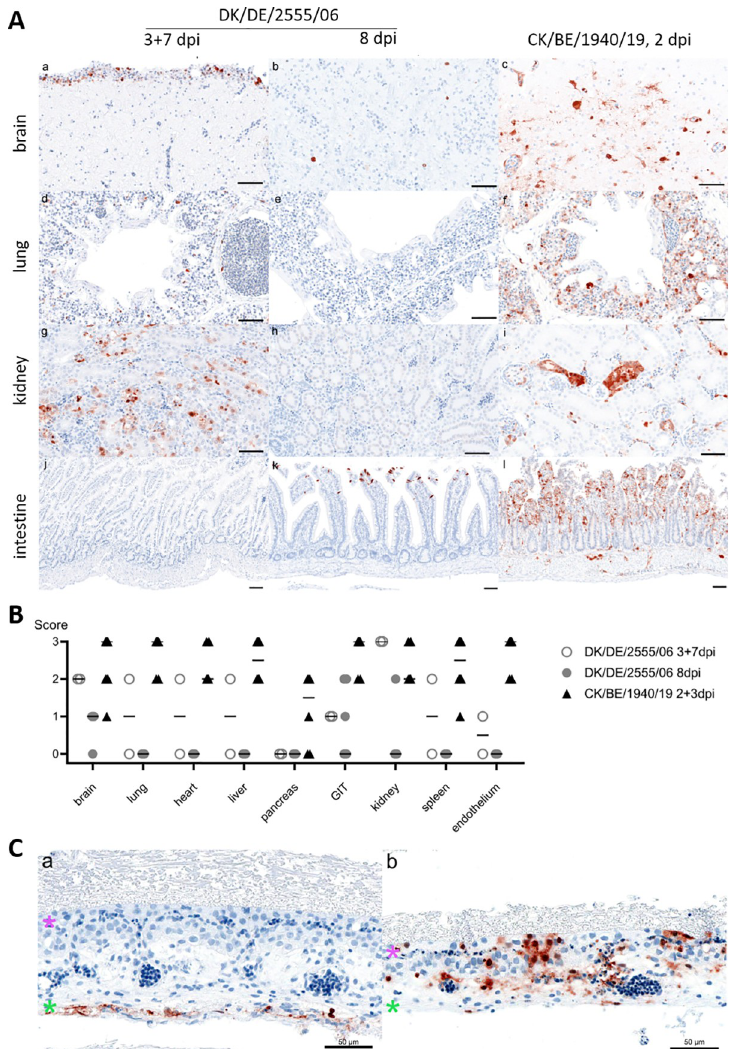
Fig 3. Tissue tropism of DK/DE/2555/06 and CK/BE/1940/19 following ICPI and inoculation of embryonated chicken eggs. (A) Representative images of IAV matrix protein (M1) detected in brain (a-c), lung (d-f), kidney (g-i) and intestine (j-l), following intracerebral inoculation of day-old chicks; time points indicate days post inoculation (dpi). ABC method, AEC chromogen (red), counterstain haematoxylin (blue). Bar = 50 μ m. (B) Summary of semi- quantitative antigen detection in parenchymal cells of indicated organs. Dots represent individual animal tissue scores: 0 = no antigen, 1 = focal to oligofocal, 2 = multifocal, 3 = coalescing/diffuse. Bar indicates median, GIT = gastrointestinal tract. Details given in S1 Fig. (C) Immunohistochemical detection of IAV matrix protein (M1) in the CAM following allantoic inoculation of 10-day old embryonated SPF chicken eggs with either (a) DK/DE/2555/ 06 or (b) Ck/BE/1940/19 isolate. Indicated chorionic (pink asterisk) and allantoic epithelium (green asterisk). ABC method, AEC chromogen (red), counterstain haematoxylin (blue). Bar = 50 μ m. antigen restricted to the site of inoculation and abundant signal in renal tubules, but not in lung or heart tissues and a complete lack of endothelial cell tropism. All remaining eight birds showed less abundant lesions and viral antigen, most consistently affecting the inoculation site (brain). Some birds showed antigen stain in peripheral organs including the kidney and intes- tine. Unlike to CK/BE/1940/19 infection, endotheliotropism was not evident in chickens euthanized at the end of the experiment at 8 dpi. Details including specifically affected cell types are given in S1 Fig .